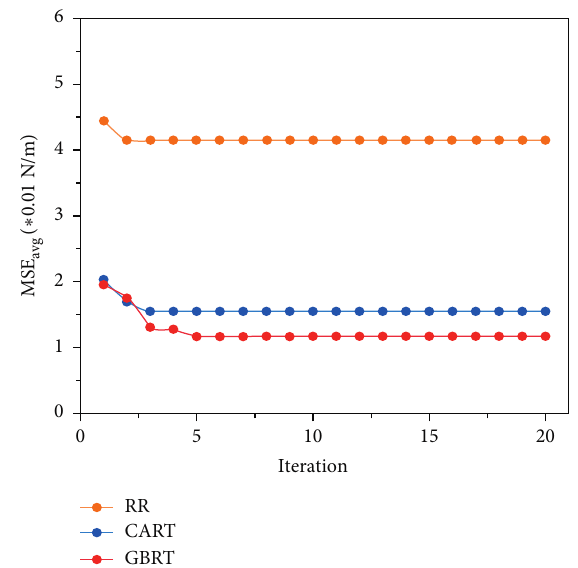
Figure 6: Minimum MSE value versus iterations in the training process.